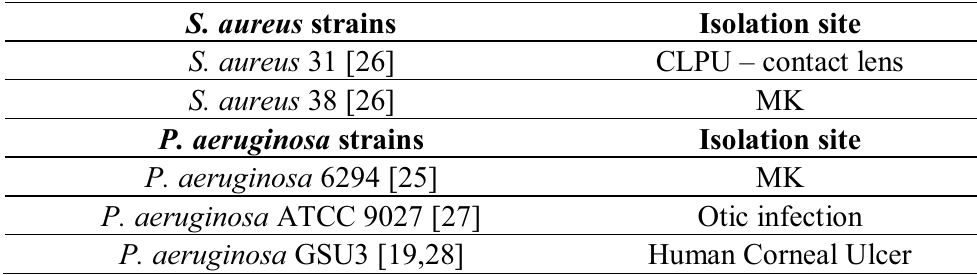
Table 2. Details of bacteria used in the